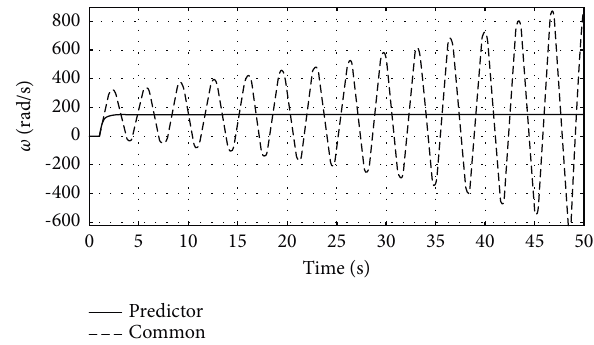
controller with a ∞